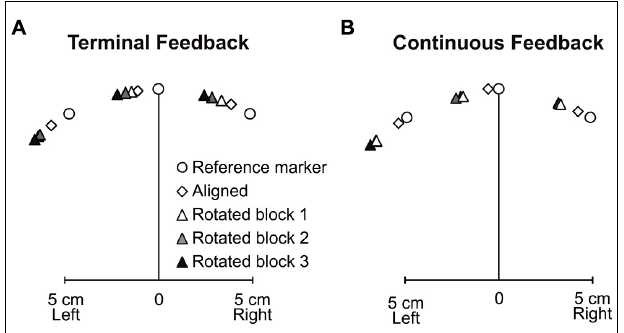
FIGURE 5 | Mean 2-D proprioceptive biases for the (A) terminal feedback experiment and (B) continuous feedback experiment (adapted from Salomonczyk etal., 2011). Subjects estimated their hand position relative to reference markers (open circles) following aligned hand-cursor feedback training (open diamonds) and rotated hand-cursor training (first rotated block: white triangles; second rotated block: gray triangles; third rotated block: dark